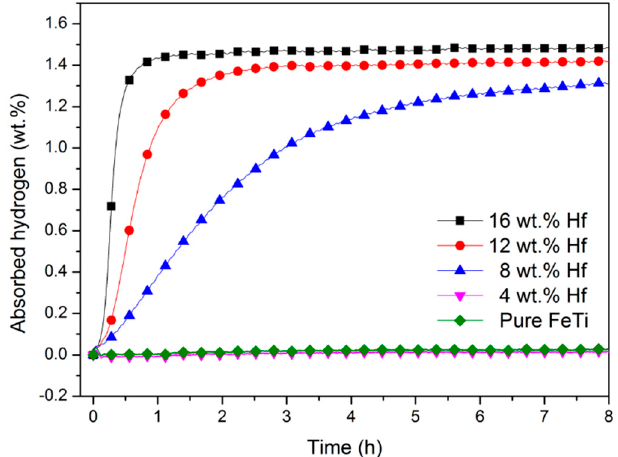
Figure 6. First hydrogenation curves of pure TiFe and TiFe doped with 4, 8, 12, and 16 wt.% of Hf. Measurements made at room temperature and under 20 bars of H 2 .